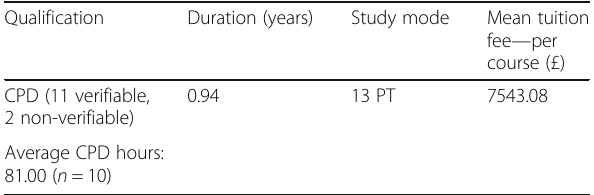
Table 4 Summary of findings from analysis of CPD courses